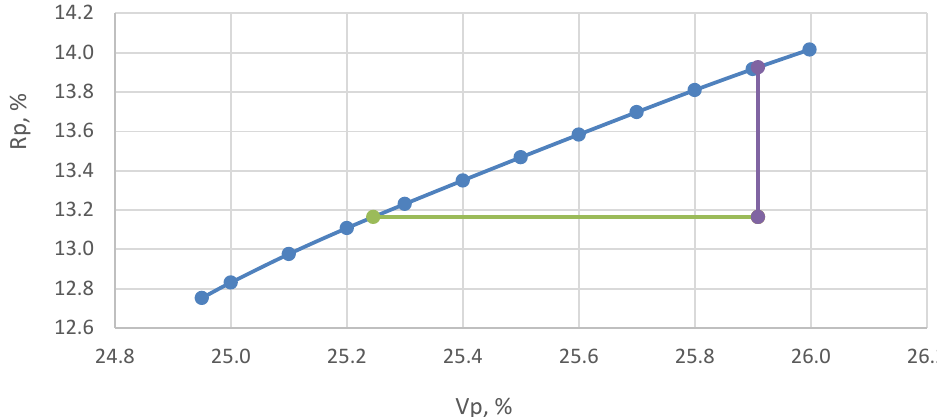
Fig. 5: The set of optimal portfolios. A square point represents a portfolio existing distribution of sown areas